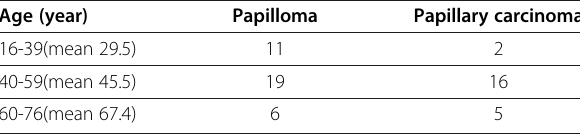
Table 1 The distribution of the different age groups of patients with papillary lesions Age